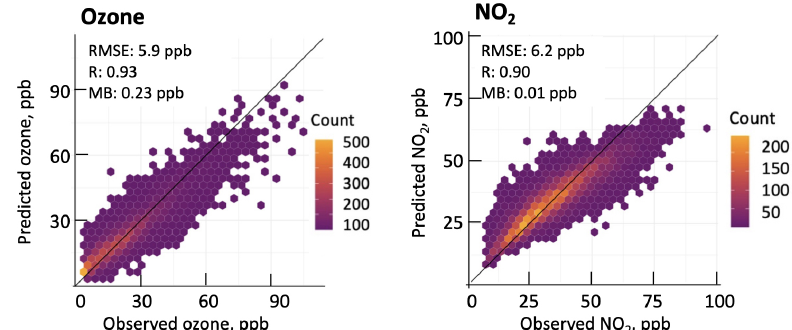
Figure 4. Performance of the random forest (RF) model in fitting 2015–2019 hourly ozone and NO 2 concentrations in the Seoul metropolitan area (SMA). The RF model is trained on hourly concentrations averaged across 79 AirKorea monitoring sites in the SMA (Fig. 3). The figure compares predicted and observed values for the 30% of data withheld from training. Comparison statistics are shown inset including the root mean square error (RMSE), correlation coefficient ( R ) and mean bias (MB). Also shown are the 1:1 lines. Count refers to the number of data points within a given (ozone, NO 2 ) data bin (individual symbol).